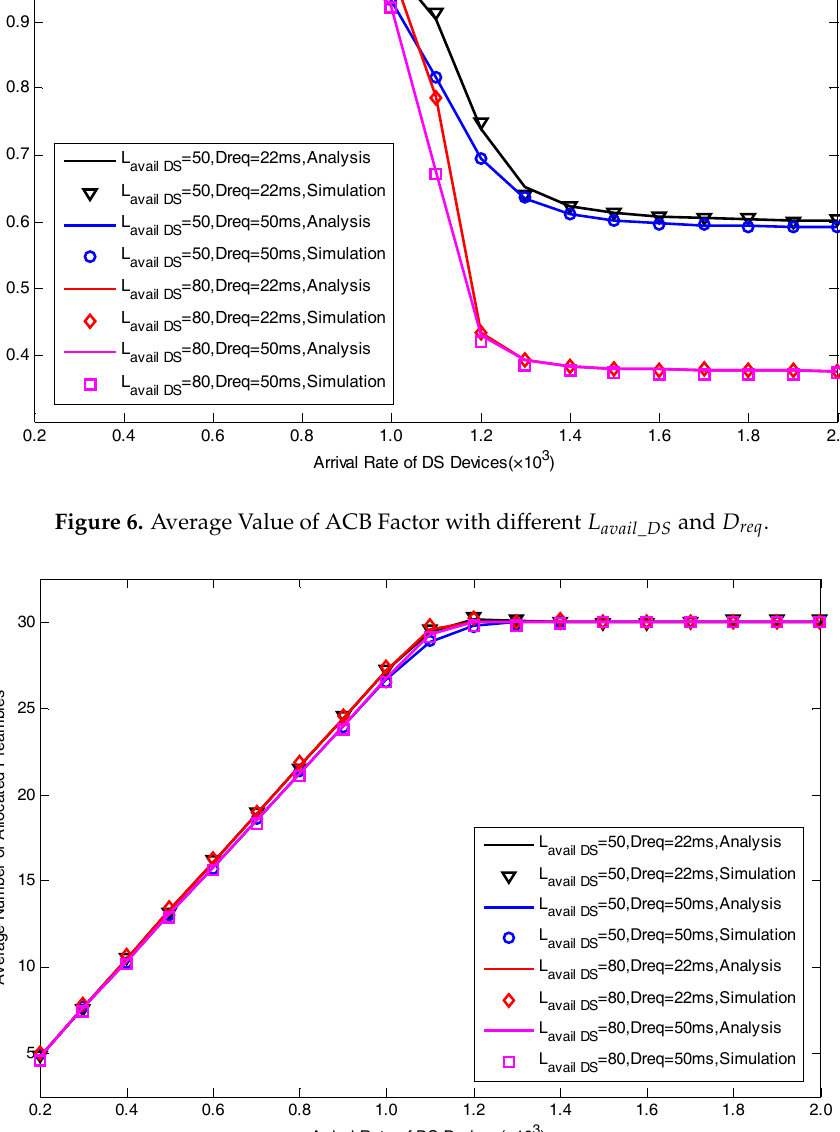
Figure 7. Average Number of Allocated Preambles with different L avail _ DS and D req .